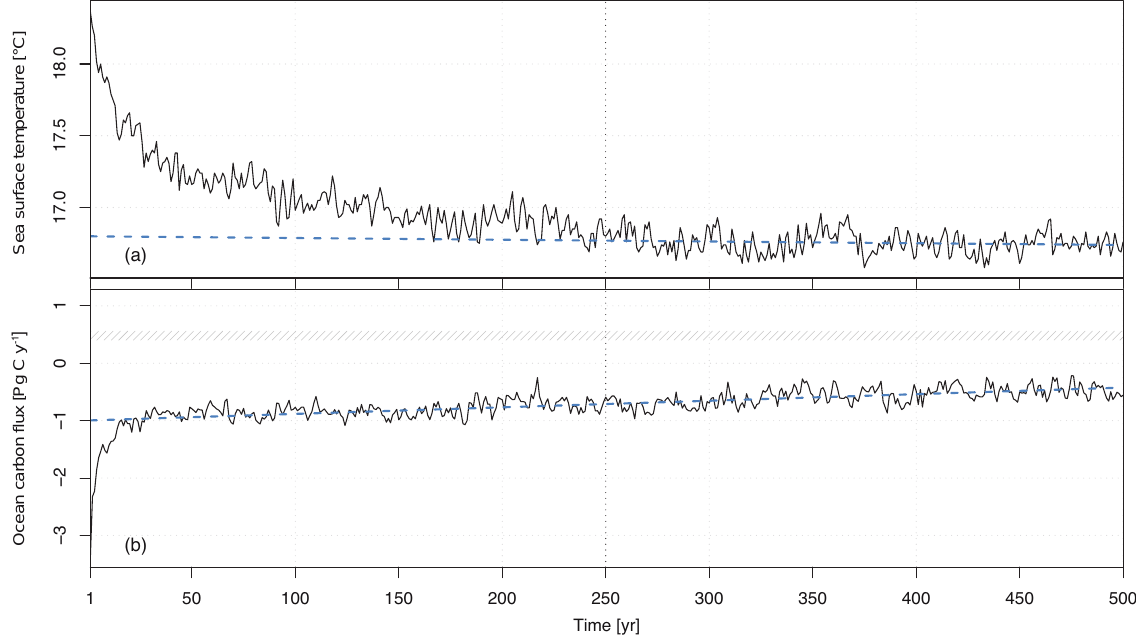
Figure 2. Time series of two climate indices over the 500-year spin-up simulation of IPSL-CM5A-LR. They represent the globally averaged sea surface temperature (a) and the global mean sea-air carbon flux (b) . For sea-air carbon flux, negative value indicates uptake of carbon. Steady state equilibrium of physical components as described in Mignot et al. (2013) is reached at ∼ 250 years and is indicated with a vertical dashed line. Drifts in sea surface temperature and global carbon flux are indicated with dashed blue lines. They are computed using a linear regression fit over years 250 to 500. Hatching on panel (b) represents the range of inverse modeling estimates for preindustrial global carbon flux as described in Mikaloff Fletcher et al. (2007), i.e., 0.03 ± 0.08 plus 0.45PgCy − 1 corresponding to the riverine-induced natural CO 2 outgassing outside of near-shore regions consistently with Le Quéré et al.